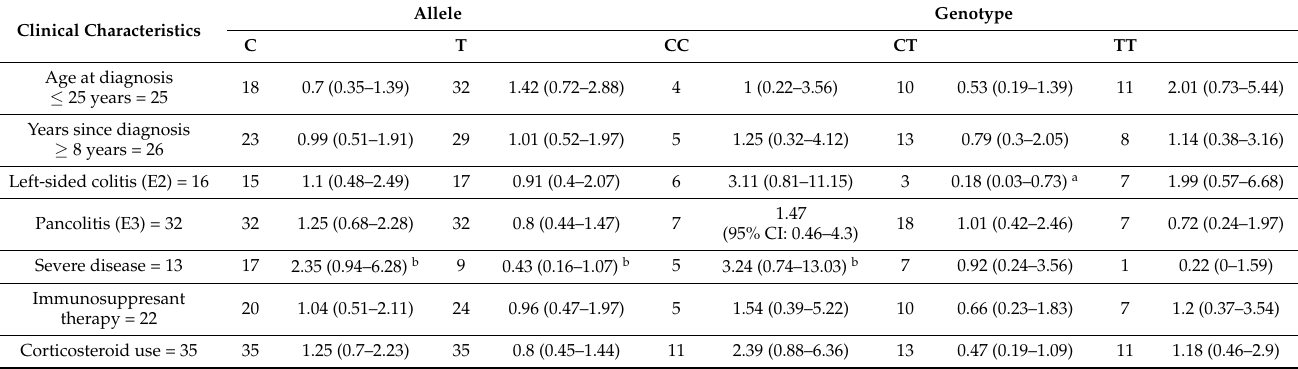
Table 5. Genotype–phenotype analysis for C3435T SNP in